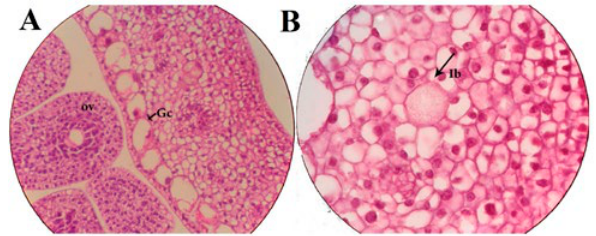
Figure 7. (A) Transverse sections of ovary wall with giant cell; (B) Transverse sections of ovary tissue with idioblast (Gc – giant cell; Ib – idioblast; ov-